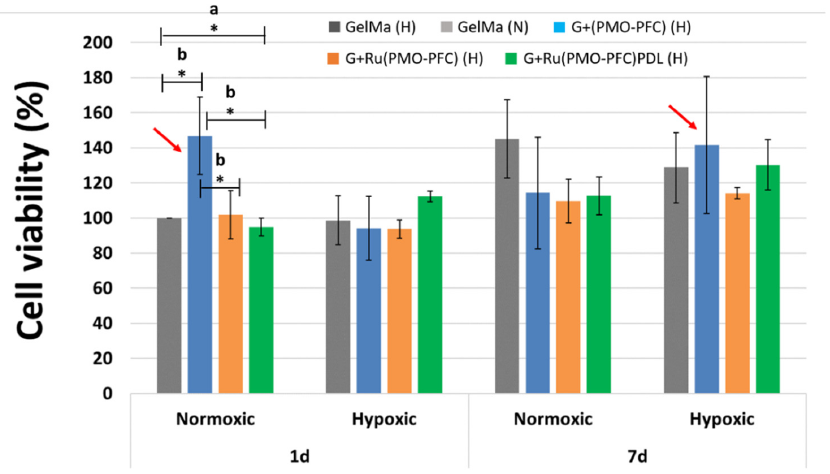
Figure 6. Cell viability of FB cells under normoxia and hypoxia conditions for 1 day and 7 days incubation times. The red arrow shows the sample with the highest effect on cell viability. ANOVA: p < 0.05 (*), a = significant difference between four groups, b = significant difference between two groups. Number of repeated experiments (N) = 3.